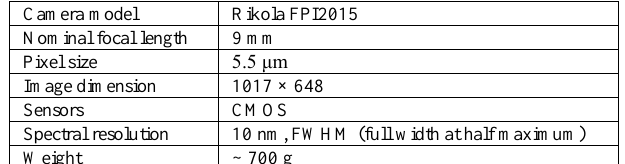
Figure 1. Rikola camera model and a sketch representing its internal system. Source: Oliveira et al. (2016).